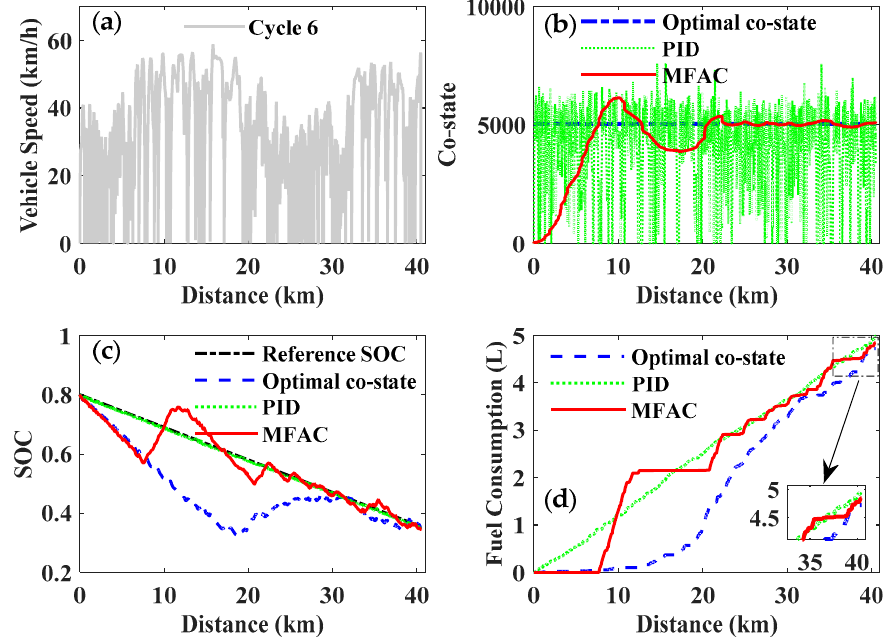
Figure 23. The simulation results of driving Cycle 6. ( a ) Driving cycle; ( b ) Co-state; ( c ) SOC; ( d ) Fuel consumption.